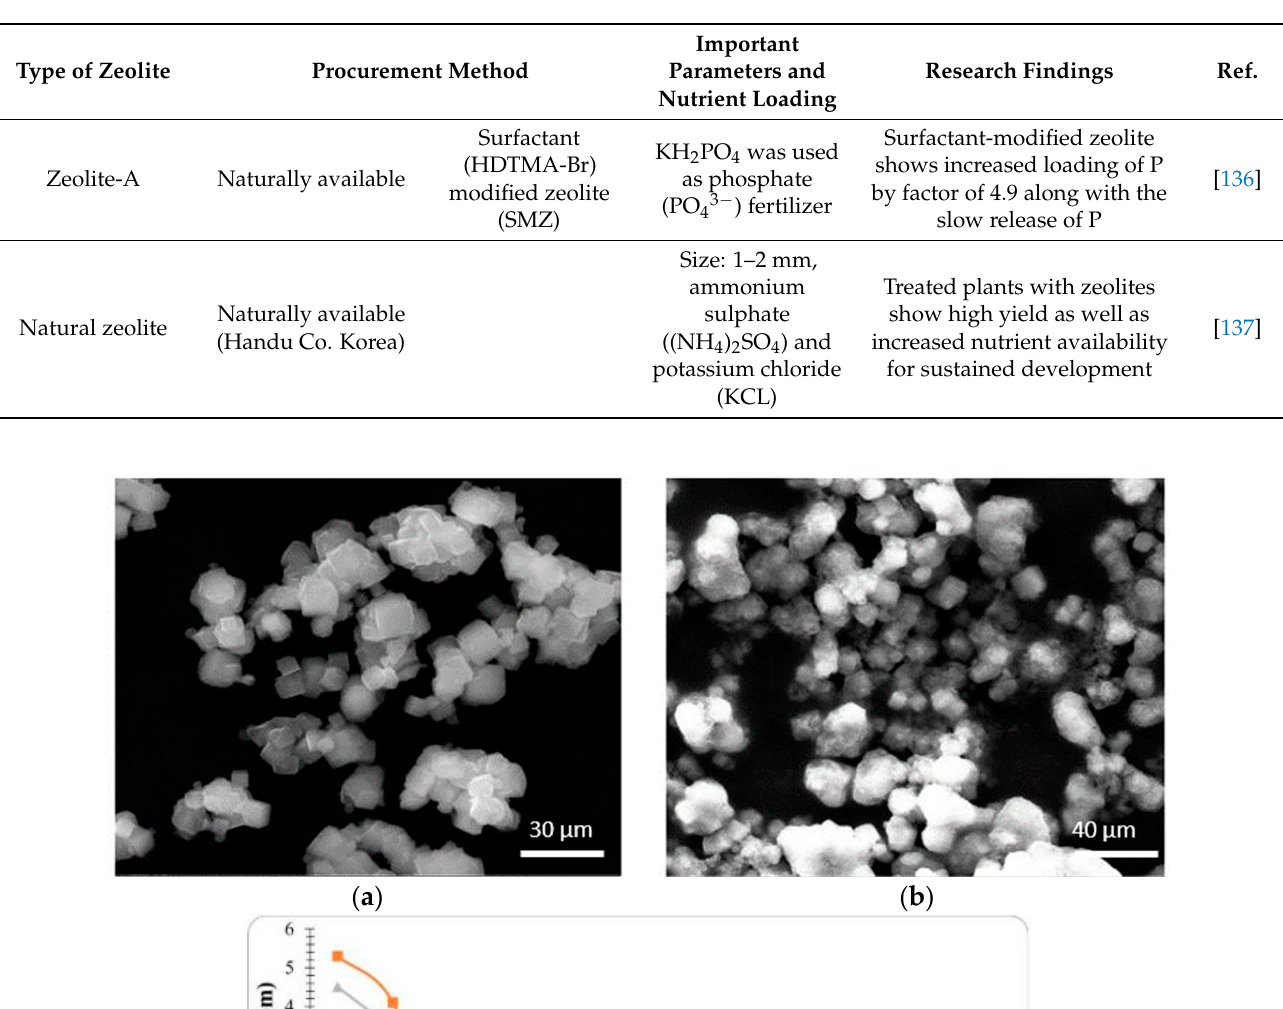
Figure 8. Reproduced from [133]: ( a ) Nano-zeolite; ( b ) zinc-loaded Nano-zeolites; ( c ) release study of zinc from nano-zeolite in comparison to zinc sulfate.